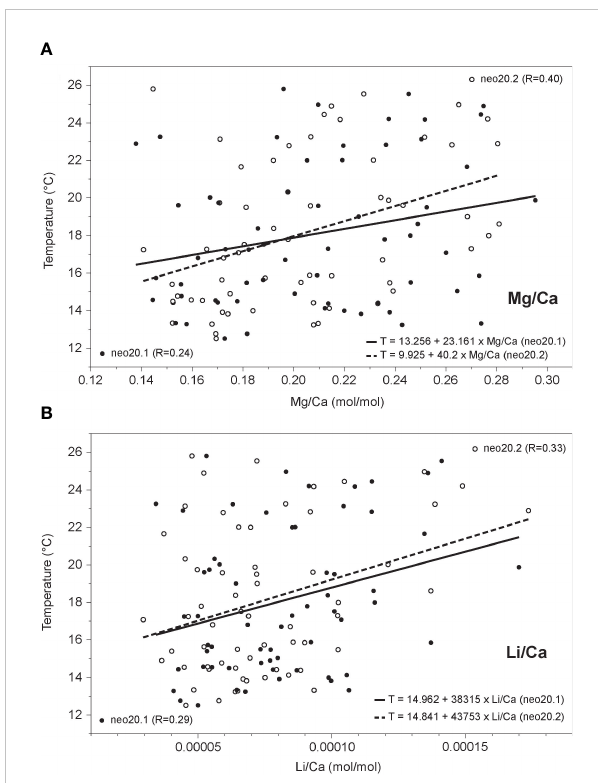
FIGURE 8 Comparison of (A) Mg/Ca and (B) Li/Ca ratios to in situ temperature (2011-17) for sample neo20. Linear regressions for monthly data are signi fi cant (p<0.01), with regression line shown in solid (transect neo20.1) and stippled (transect neo20.2). Equations and correlation coef fi cients (R) are shown for each regression. Both ratios are positively correlated to